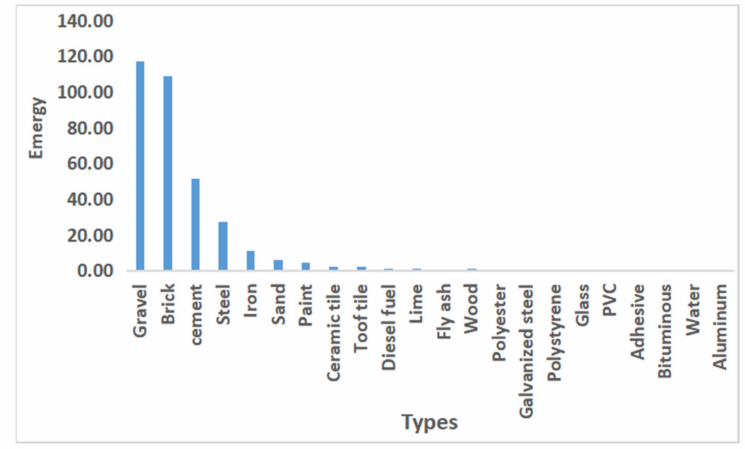
Figure 8. The proportion of each material input (unit: 10 17 sej).